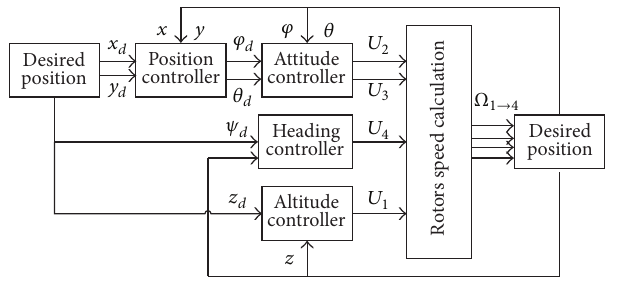
Figure 3: Quadrotor control